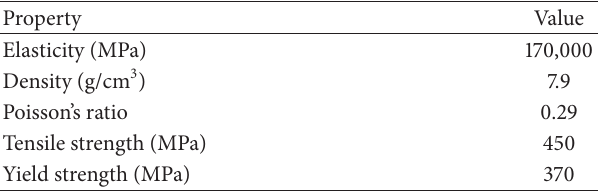
Figure 3: Plastic strain and true stress curve. Table 1: Material properties of